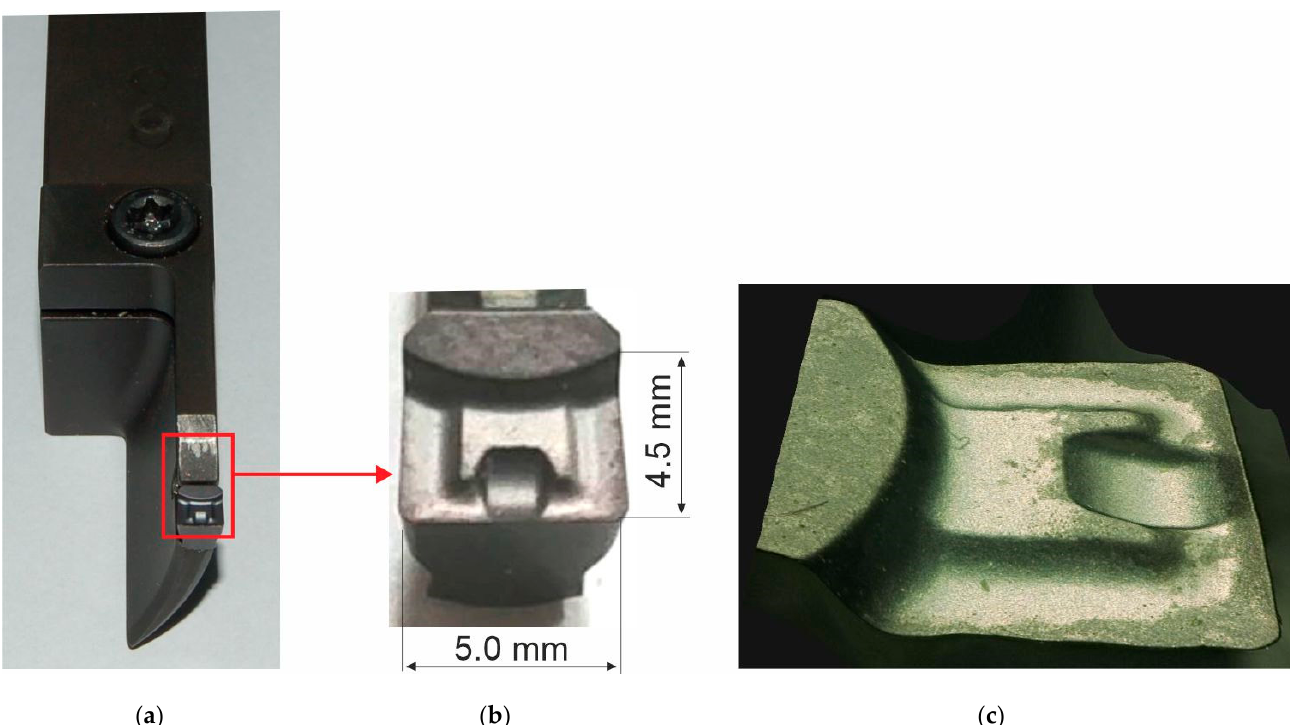
Figure 3. ( a ) Kennametal tool; ( b ) top and dimensions; ( c ) side views of the rake face [36]. The initial experimental orthogonal turning tests for the full tube thickness, a p = 2.77 mm, indicated a characteristic form of the chip inside the surface related to different chip flow speeds on the rake face. The areas 1 and 2 on the chip and on the tool rake face were measured and determined experimentally. The width of area 1 on the insert face was 0.5 mm, and the width of area 2 was 1.77 mm, (Figure 4).